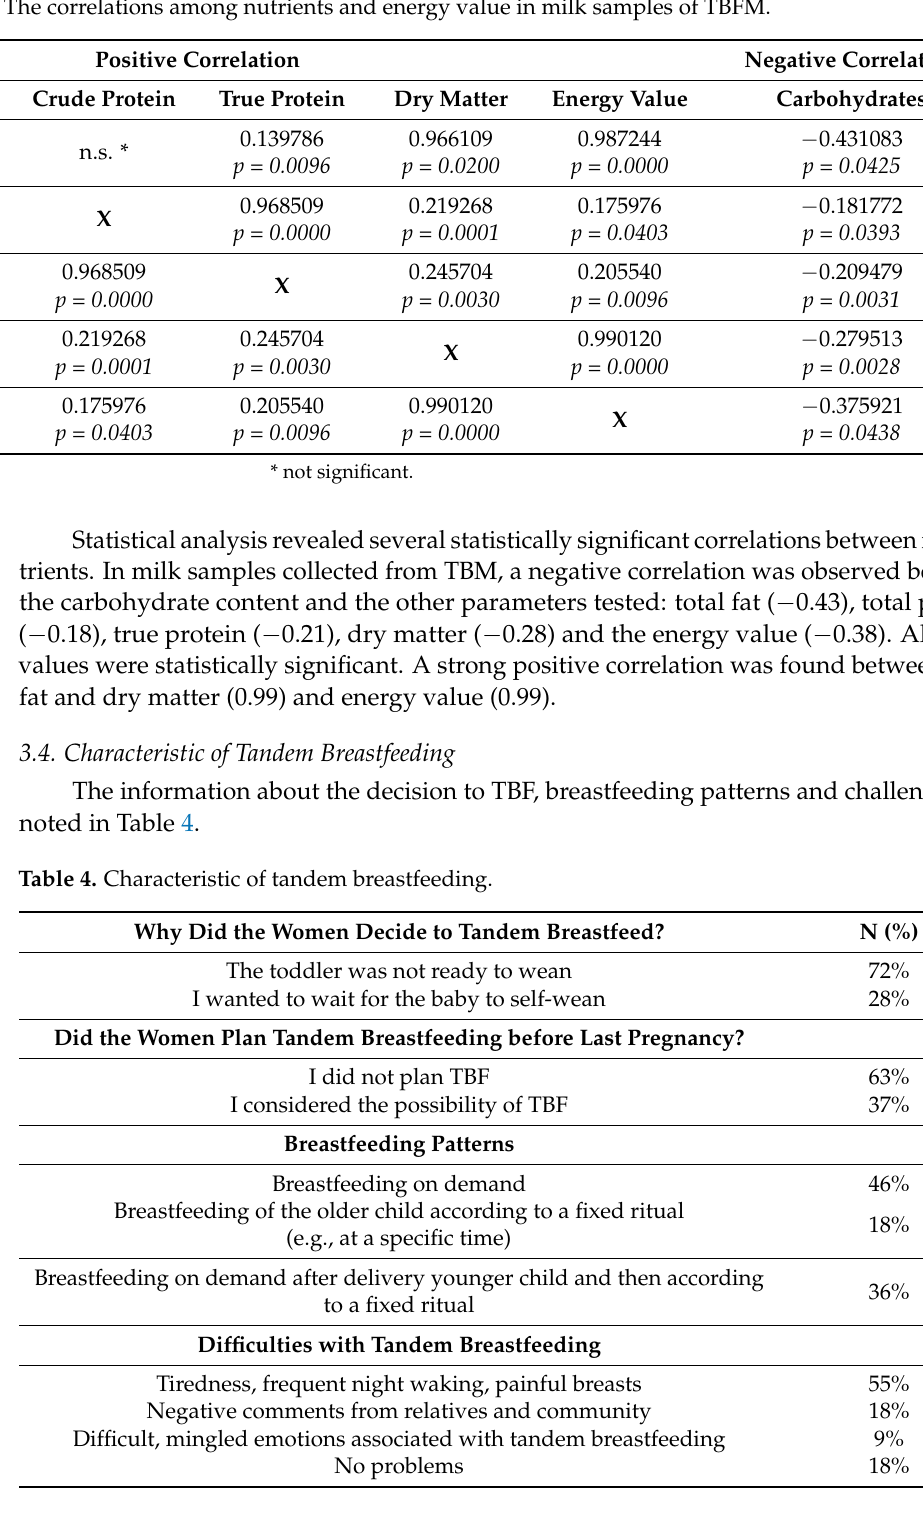
Table 3. The correlations among nutrients and energy value in milk samples of TBFM.